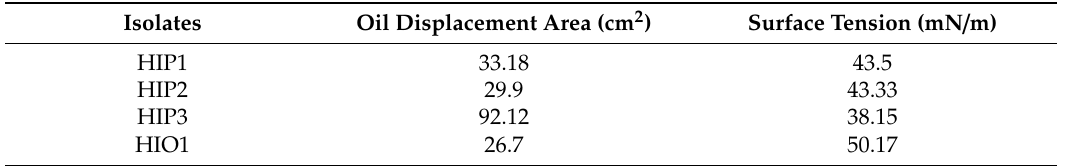
producing bacteria.